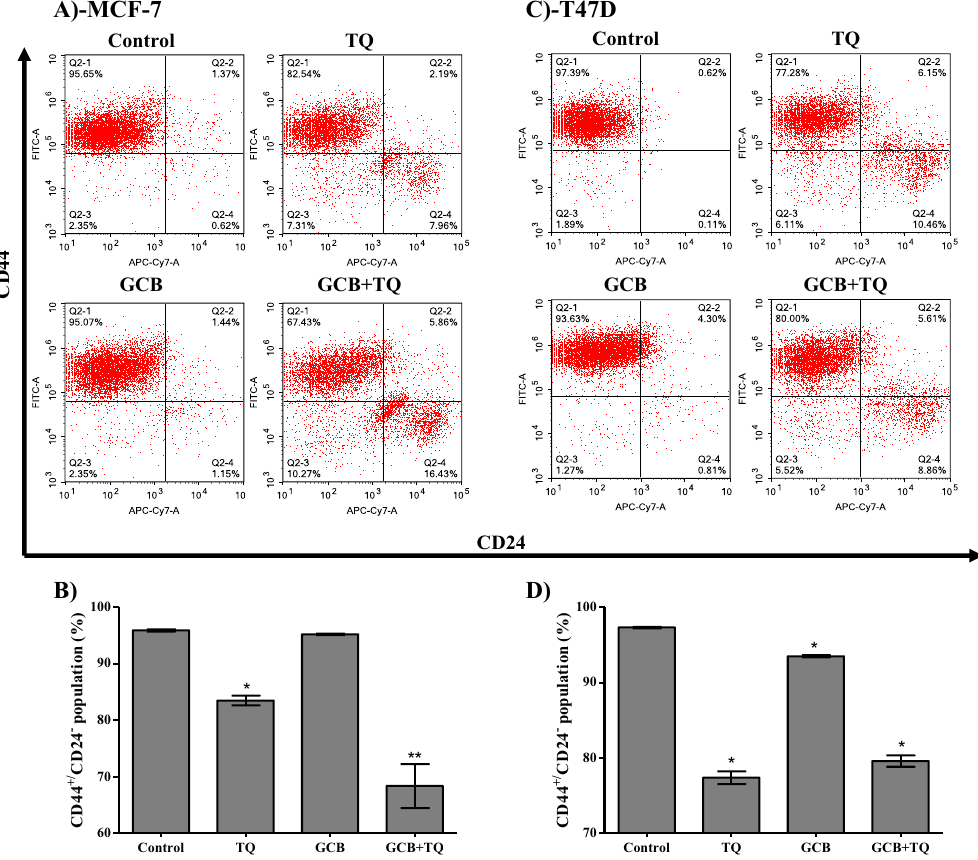
Figure 6. Effect of GCB, TQ and their combination on the expression of CD44 and CD24 stem cell markers. MCF-7 ( A ) and T47D ( B ) cells were exposed to GCB, TQ or their combination for 24 h. Expression levels of CD44 and CD24 were assessed using flow cytometry plotted as percentage of total events. Data is presented as mean ± SD; n = 3. * Significantly different from control group. ** Significantly different from GCB